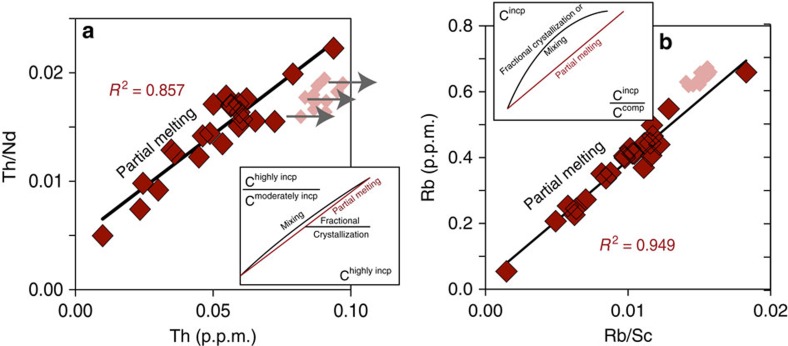
Variation in trace element composition of the equatorial MAR melt inclusons.(a) Th/Nd ratio as a function of Th content (p.p.m.) for the equatorial melt inclusions (red diamonds) and matrix glasses (pink diamonds). (b) Rb content (p.p.m.) as a function of Rb/Sc ratio for the equatorial MAR melt inclusions and matrix glasses.